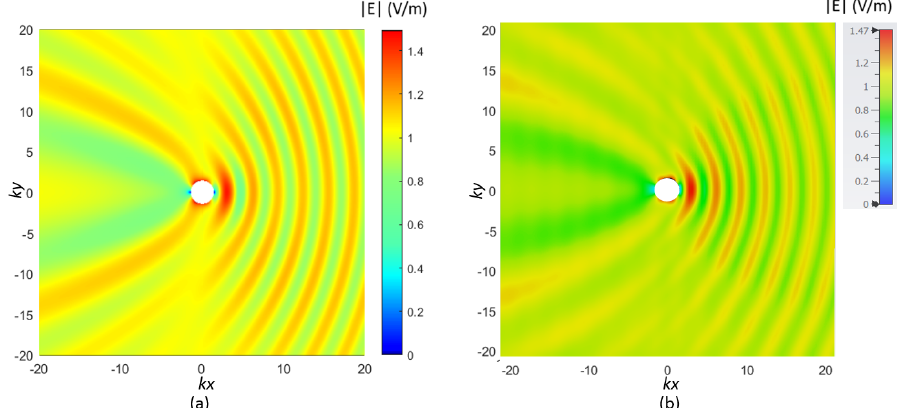
Figure 8. Real and imaginary parts of E y along the x -axis and comparison with the results obtained through CST Microwave Studio ( a ); magnitude of the E-field across the xz -plane ( b ). Used parameters were as follows: θ 0 = 30 ◦ , ka = 10.1, kb = 1.4177, c = 10, ξ 0 = 1.01, d = 20, m t = 14. TE polarization.